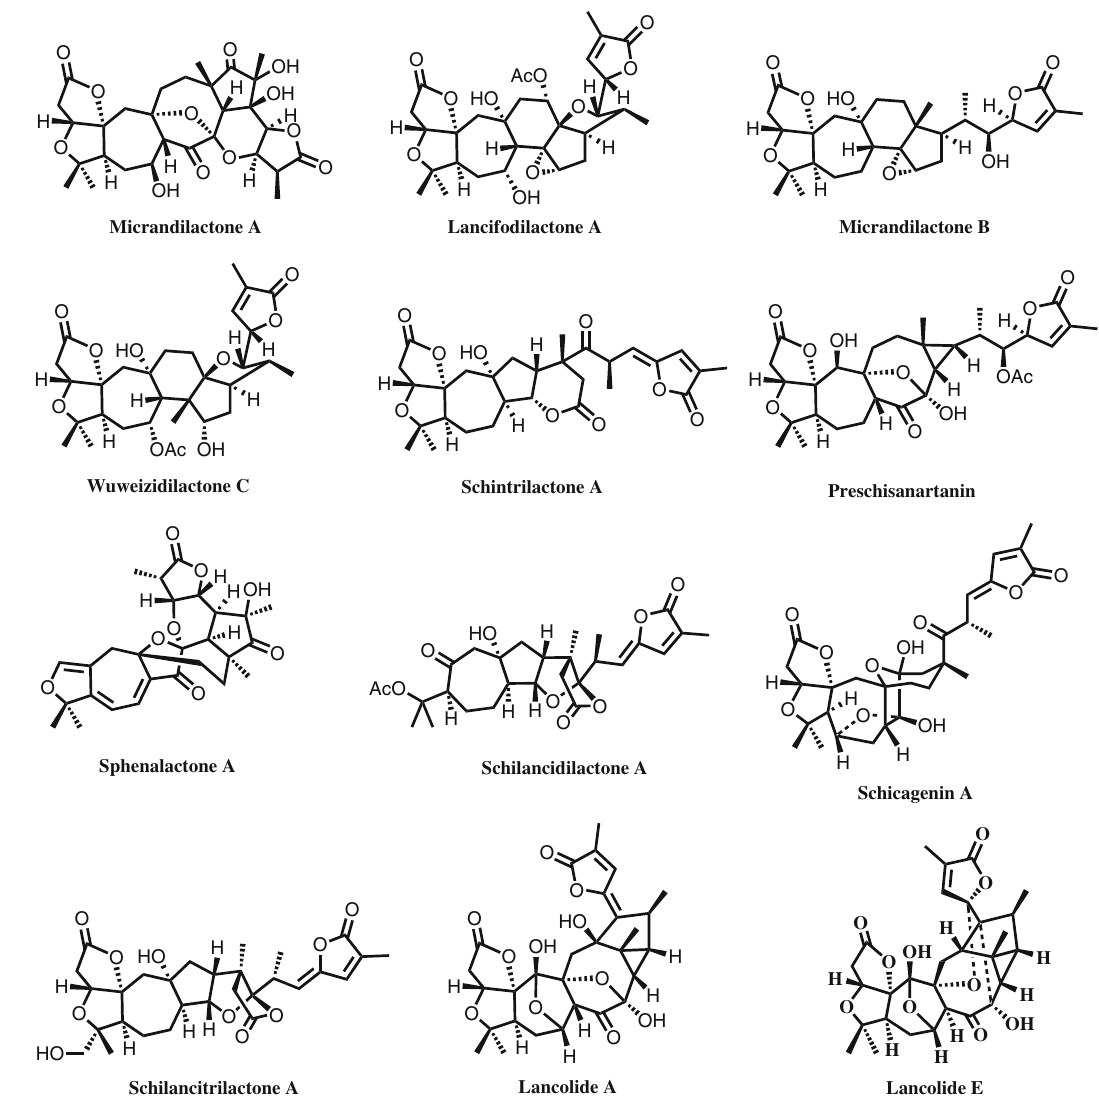
Fig. 7 Representative novel SNTs from Schisandraceae